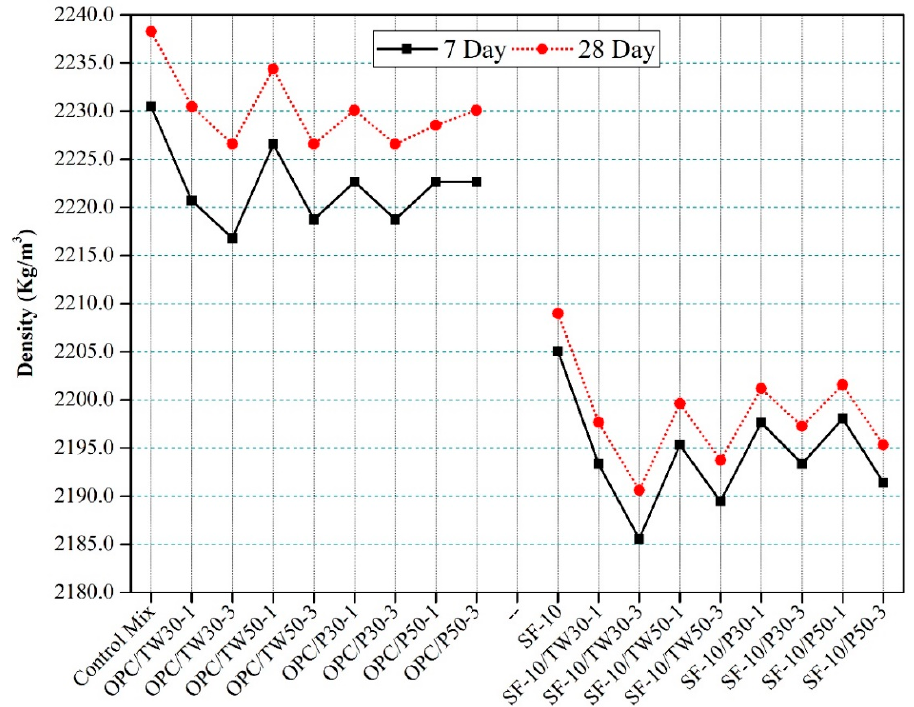
Figure 9. Densities of specimens made with tea waste and perlite particles with OPC and SF as binders.